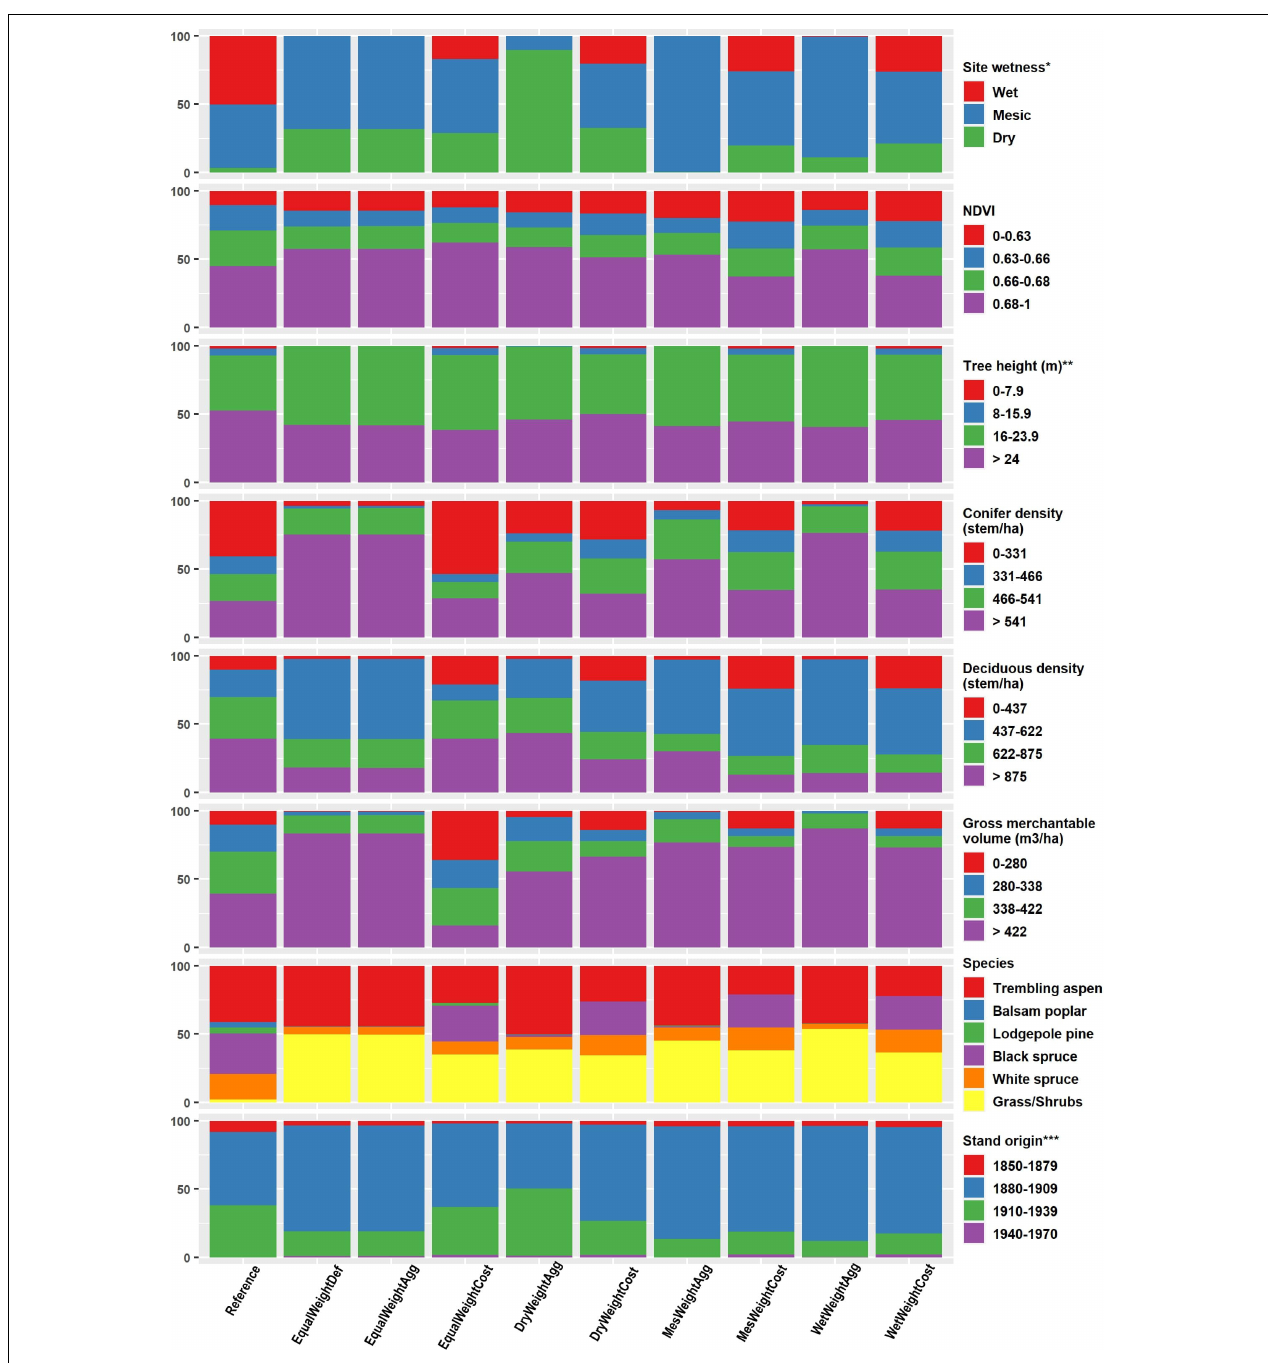
FIGURE 4 | Compositional plots comparing forest stand structure between the reference retention design and the scenarios resulting from Zonation. See Table 4 for information on constraints included in the various scenarios. The Y -axis displays the percentage occupied by a class based on pixel counts within retention patches for a whole scenario. * Site wetness is classified by the Depth-to-Water Index as follows: Wet = 0–0.5 m; Mesic = 0.5–2 m; dry > 2 m. ** 95th percentile of LIDAR-derived tree heights. *** Year of origin of a given stand, used to calculate stand age; excludes grassland/shrubs patches which had no estimate of stand